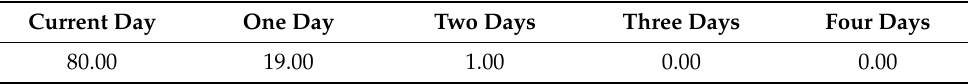
Table 7. Prediction results are based on the average of the differences between R and G in RGB values with noise.